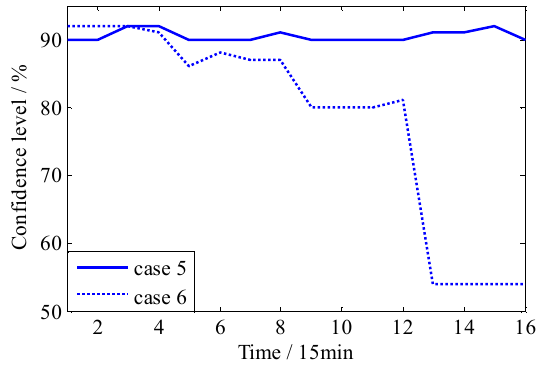
Figure 11. The optimal wind power confidence levels. Table 5. Comparison of simulation results for Case 5 and Case 6.